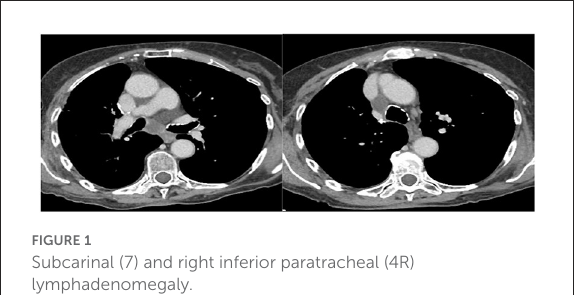
FIGURE1 Subcarinal (7) and right inferior paratracheal (4R)